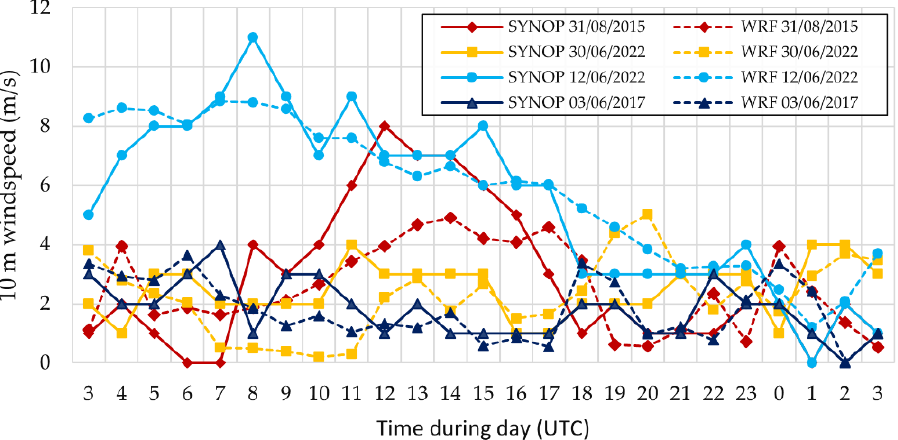
Figure 5. Comparison of predicted (WRF) and observed (SYNOP) 10 m wind speed at the